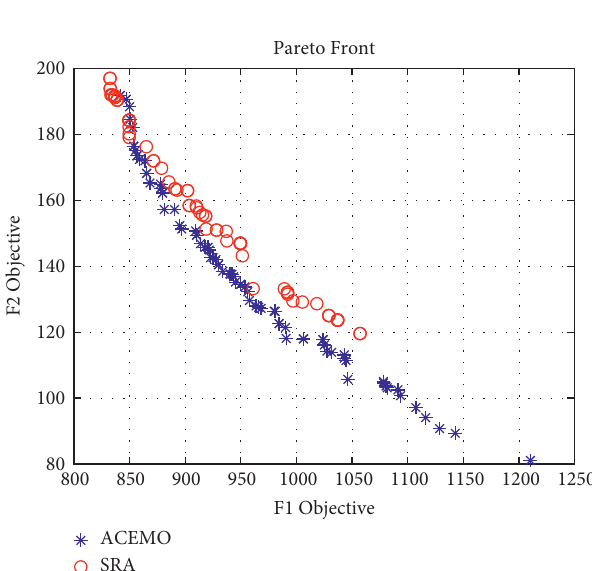
Figure 2: The Pareto front of ACEMO and SRA on microgrid problem.